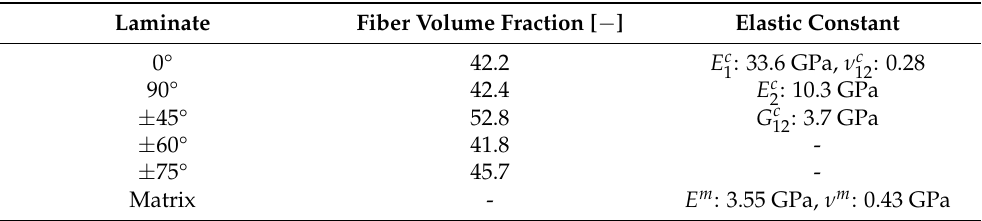
Table A1. Fiber volume fractions of the laminates and the quasi-static elastic constants in ply- coordinates determined from tests.